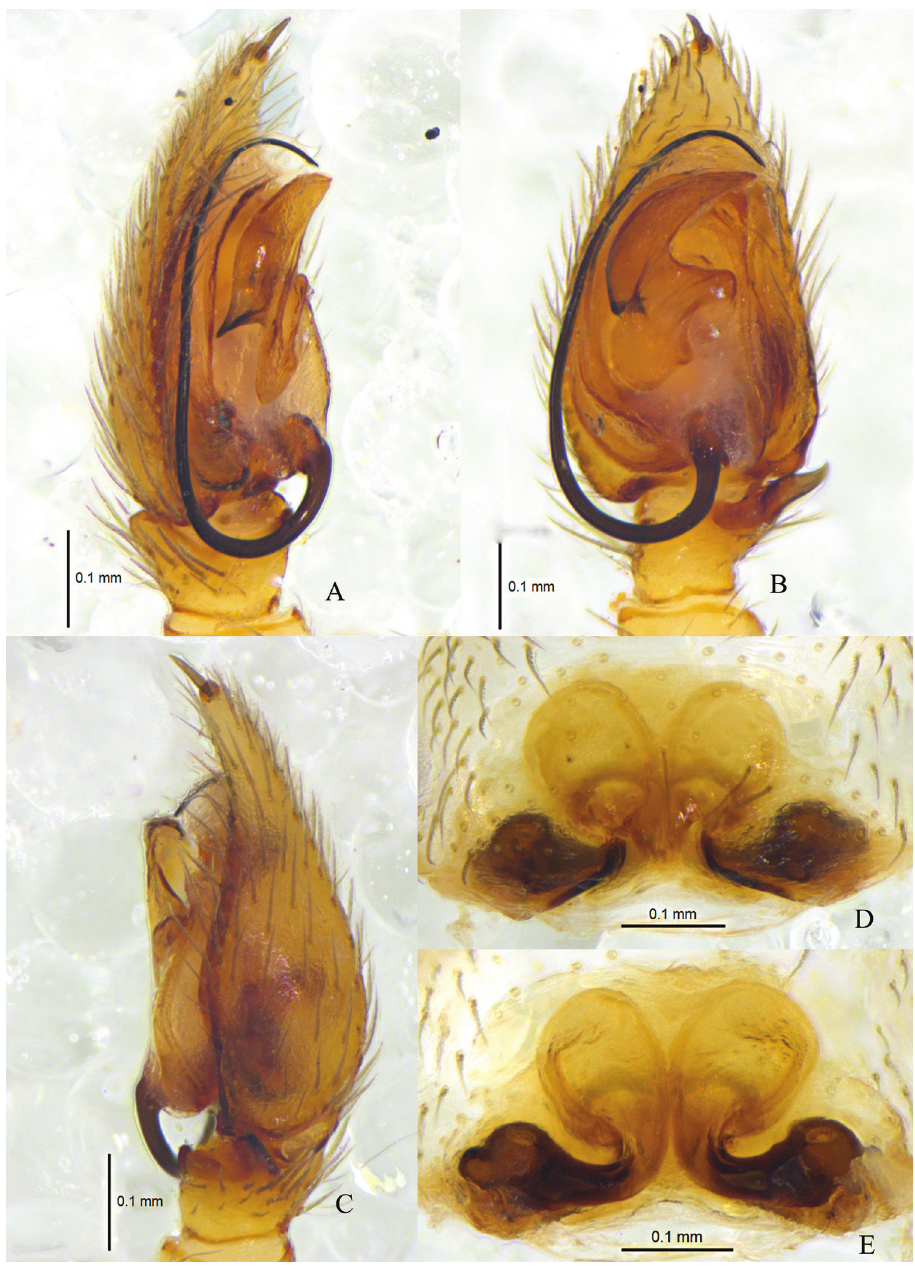
Figure 7. Zodarion ovatum sp. n., male holotype left palp ( A–C ) and female paratype ( D, E ) A Prolateral view B Ventral view C Retrolateral view D Epigynum, ventral view E Vulva, dorsal